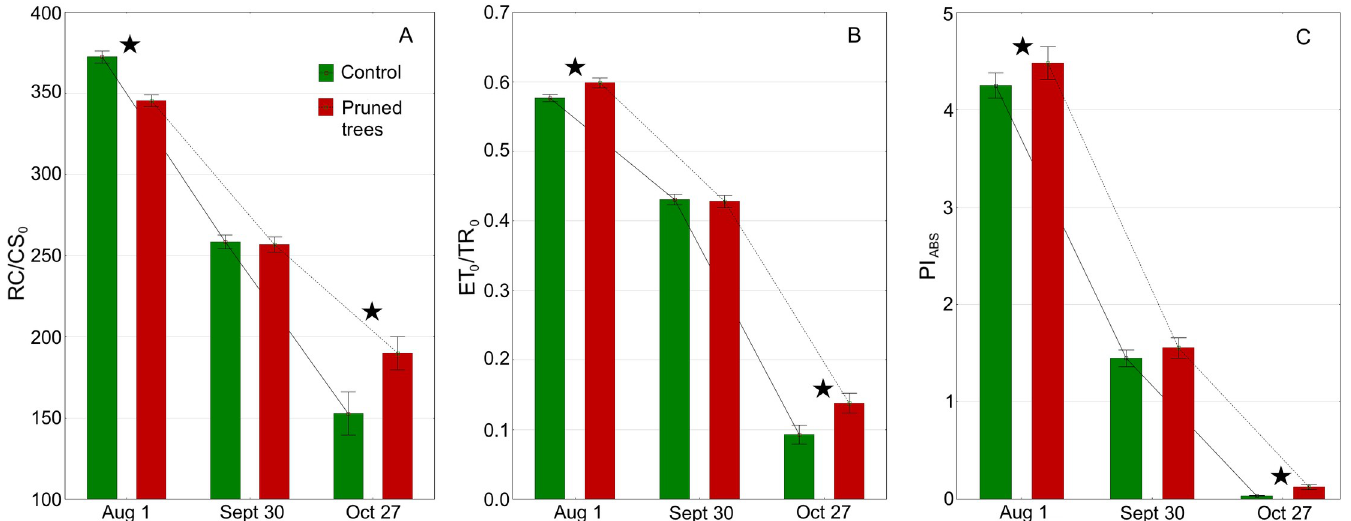
Fig 9. Changes in density of reaction centres, RC/CS 0 (a), probability of electron movement beyond Q A , ET 0 /TR 0 , (b), and performance index on absorption basis, PI ABS (c), in pruned (PT) and control (CT) trees during the first growing season after pruning. Means; whiskers and asterisks indicate SE and statistical significance,